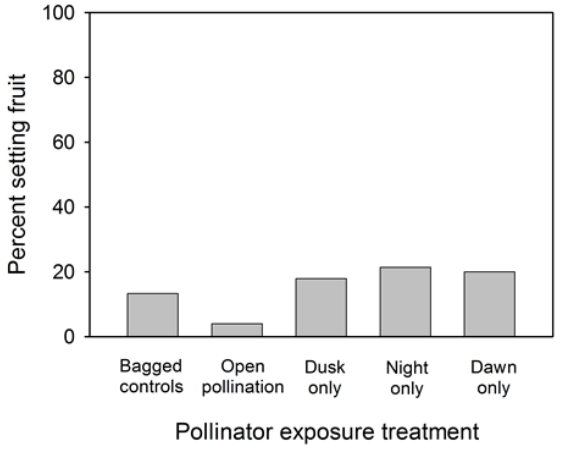
F IGURE 4. Percent of flowers setting fruit under different bagging treatments. There were no significant differences in the